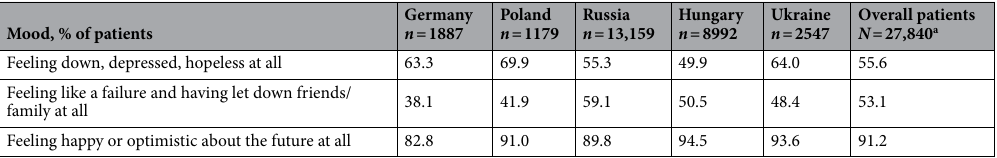
Table 3. Proportion of women reporting impact of endometriosis (and endometriosis treatment, if received) on mood. a Patients from Switzerland are not presented here as a subcategory owing to low patient numbers (n = 74). a Included women reporting scale values of ≥ 1 to indicate how often they experienced a given mood or feeling, with 0 (never), 1 (rarely), 2 (sometimes), 3 (often), and 4